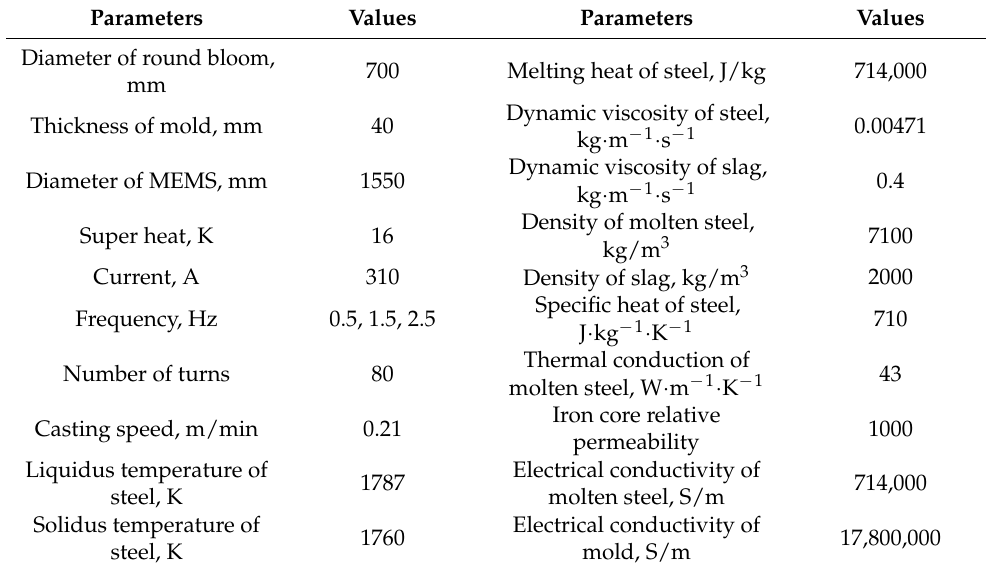
Table 1. Simulation parameters in this